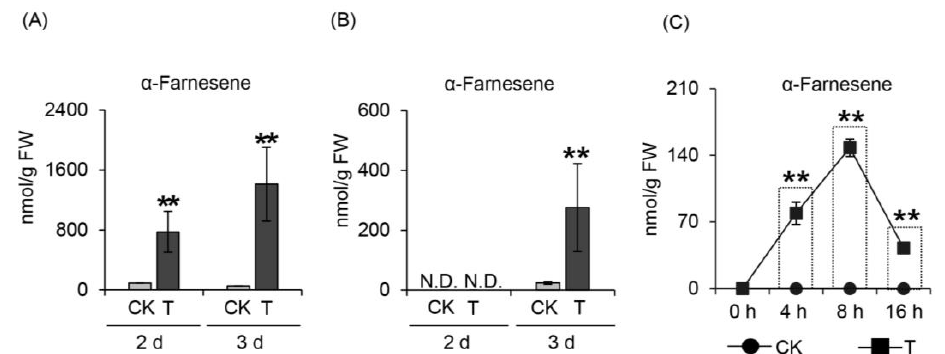
Figure 1. The formation of α -farnesene induced by two main herbivores and wounding stress in C. sinensis cv. Jinxuan. ( A ) Under tea green leafhopper attack; ( B ) Under tea geometrid attack. CK, without herbivores attack collected in di ff erent treatment time. T, with herbivores attack collected in di ff erent treatment time. ( C ) Under wounding stress; CK, without continuous wounding stress collected in di ff erent treatment time. T, with continuous wounding stress collected in di ff erent treatment time. Significant di ff erences between control and treatment at the same treatment time are indicated (** p ≤ 0.01). N.D., not detected; FW, fresh